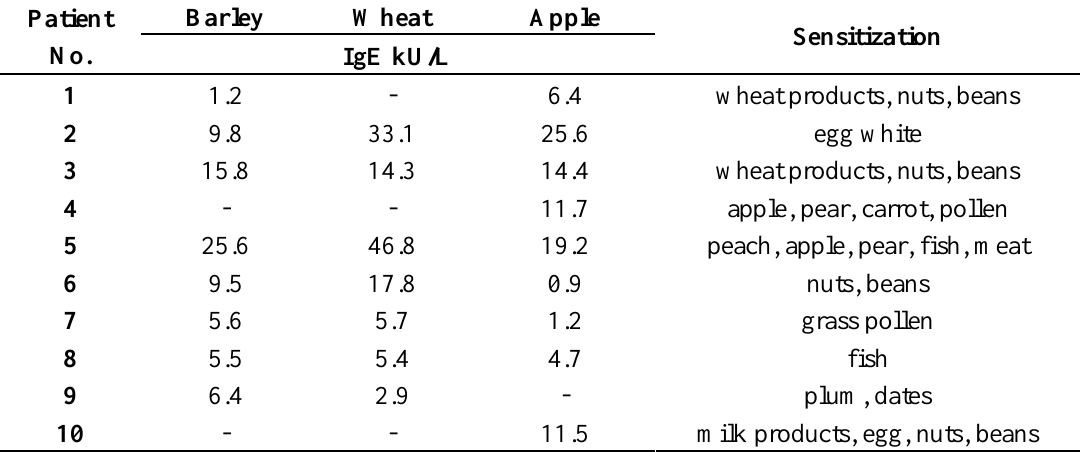
Table 1. Characteristics of sera from patients with food allergy.